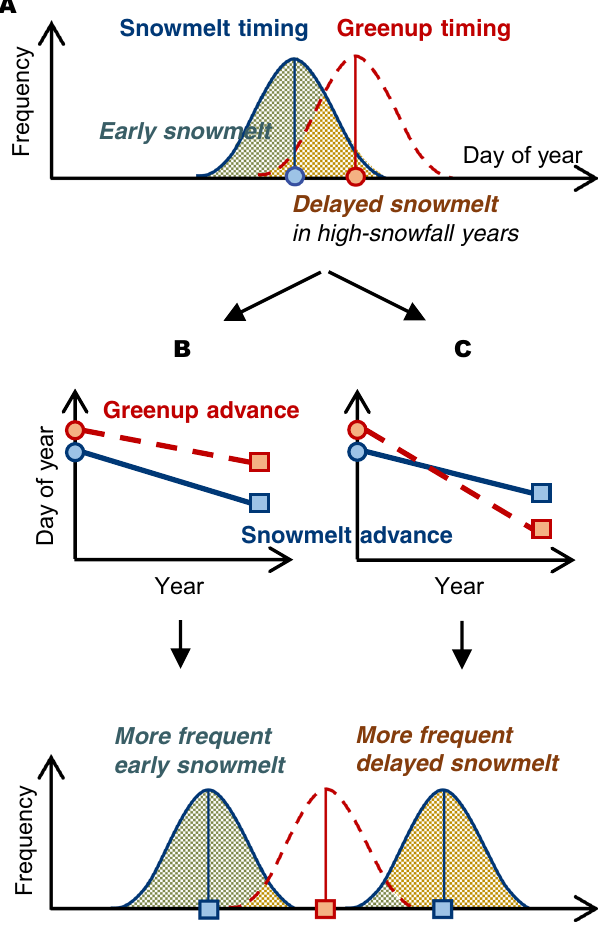
Fig. 1 Schematic illustration of long-term trends of greenup and snowmelt timings and the resultant effects. A In a present-day ecosystem, snow cover usually melts (blue circle) before greenup occurs (red circle) with interannual variations (blue and red distributions for snowmelt and greenup timings, respectively), and snowmelt is occasionally delayed when there is high snowfall (chance of early snowmelt and delayed snowmelt events in green and brown areas, respectively). The relative advance of the two timings (snowmelt in the blue solid line and greenup in the red dashed line) decide whether there will be B more frequent early snowmelt events or C more frequent delayed snowmelt events (i.e., suspending greenup from the meteorologically possible